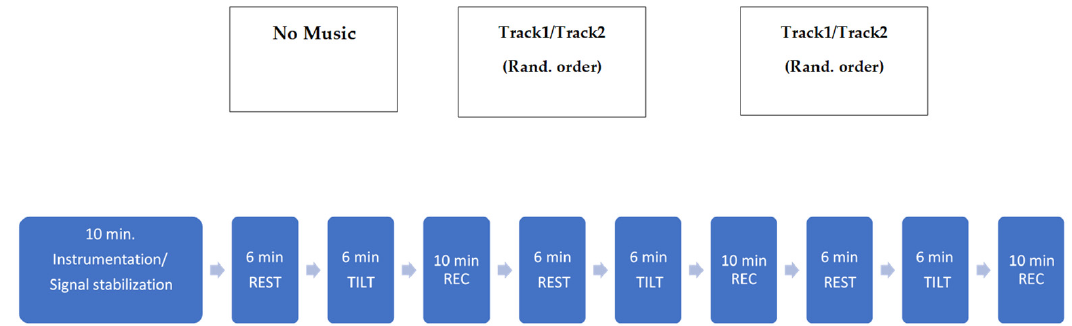
Figure 1. Track1, activating algorithmic music; Track2, relaxing algorithmic music; Rand., randomized; REST, supine condition; TILT, passive head-up tilting test; min., minutes; REC, Recovery Time .